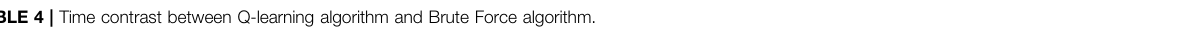
TABLE 4 | Time contrast between Q-learning algorithm and Brute Force algorithm.